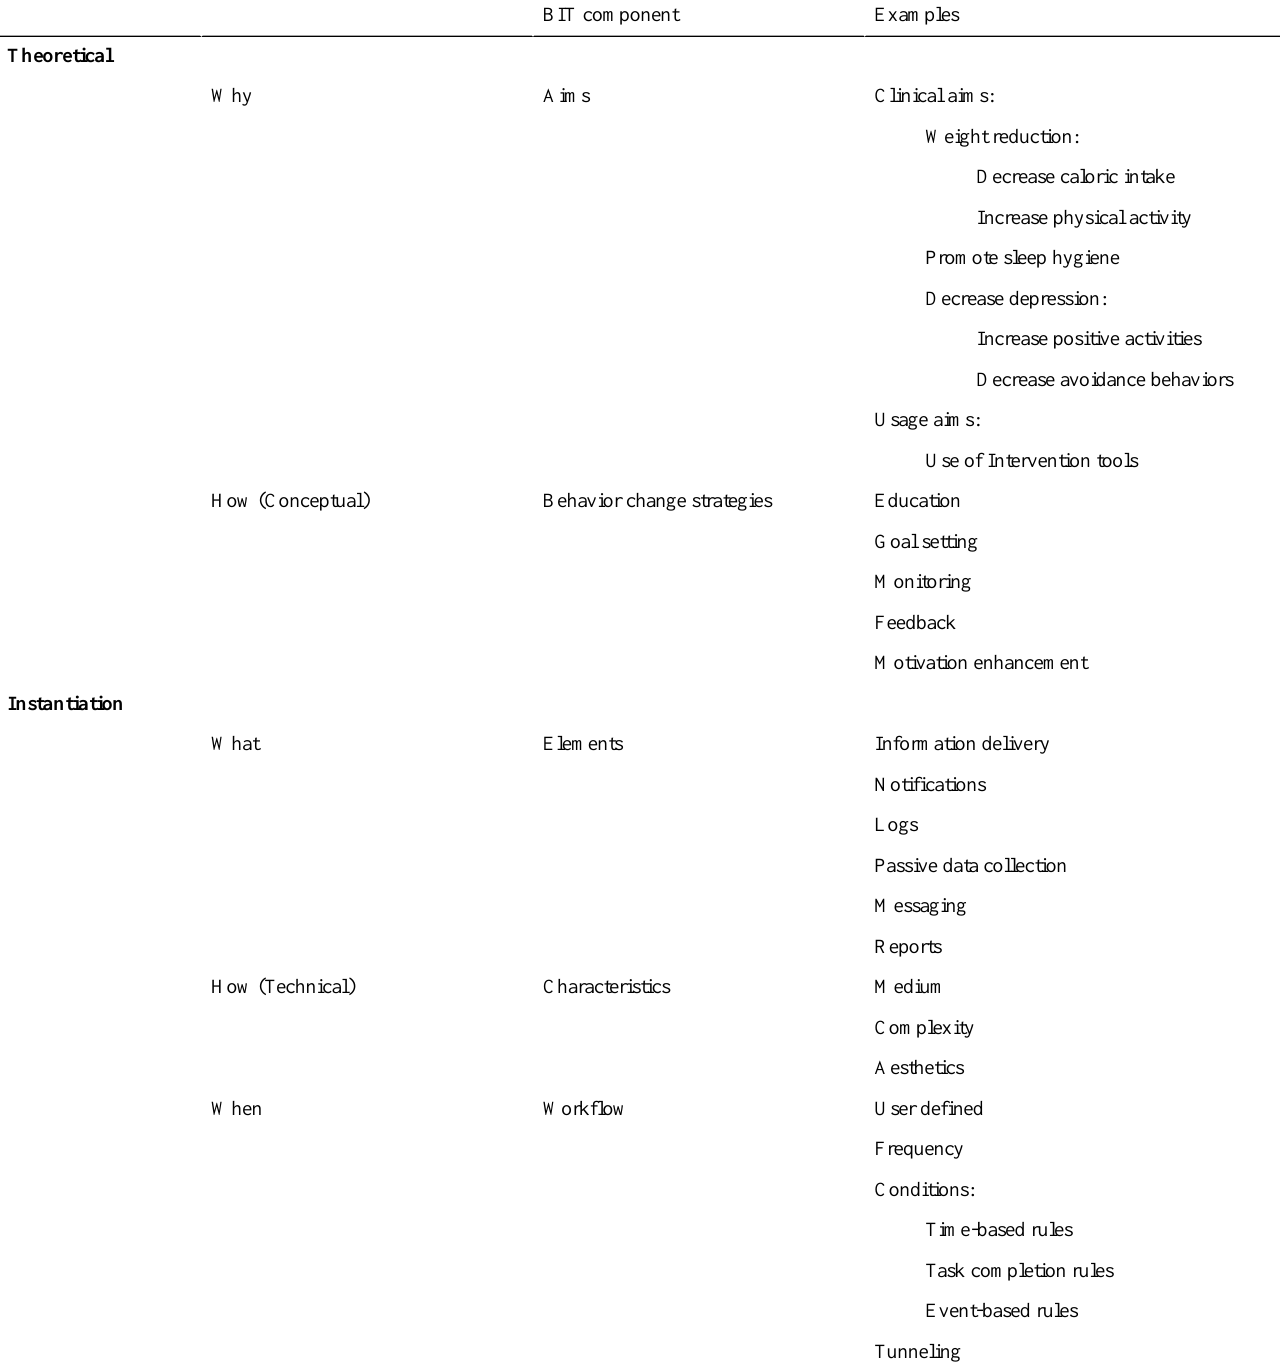
Table 1. Summary of BIT